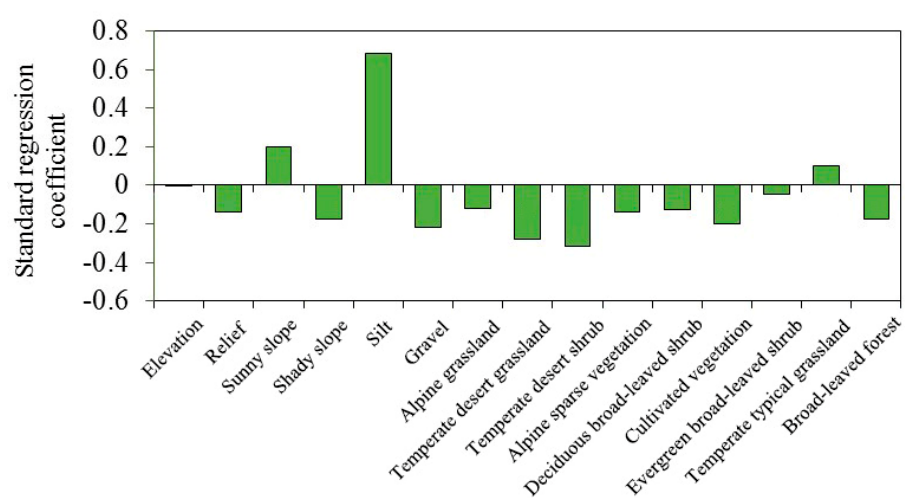
Figure 15. The standard regression coefficients of the fifteen environmental factors.